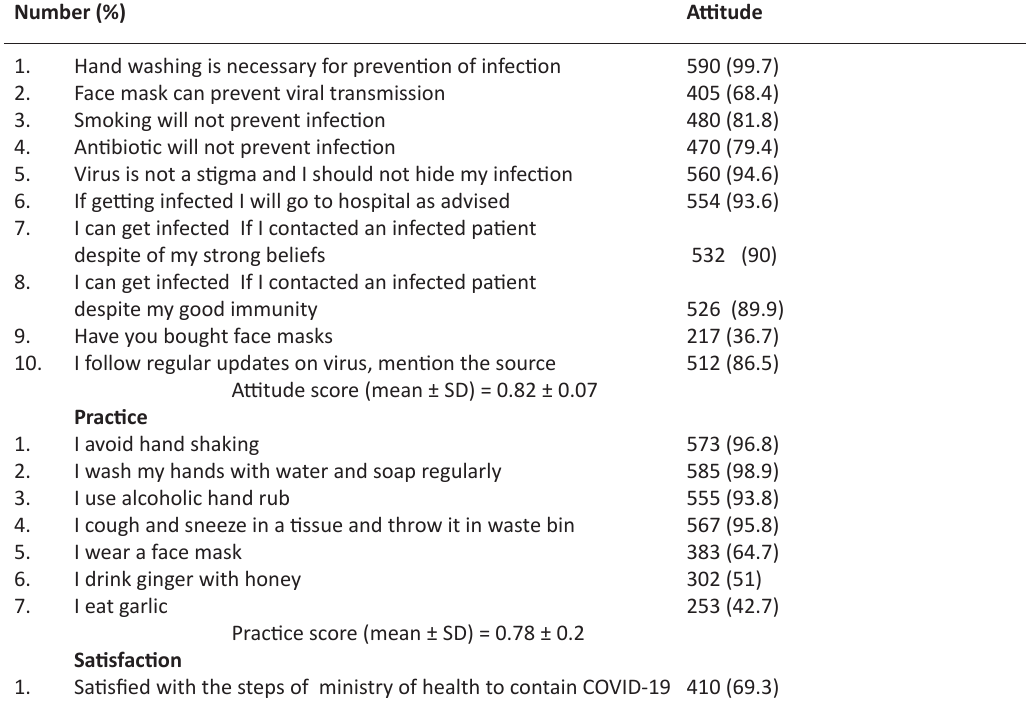
Table 3. Prevalence of attitude, practice and satisfaction among the participants (answered agree or yes), n = 592 Number (%)